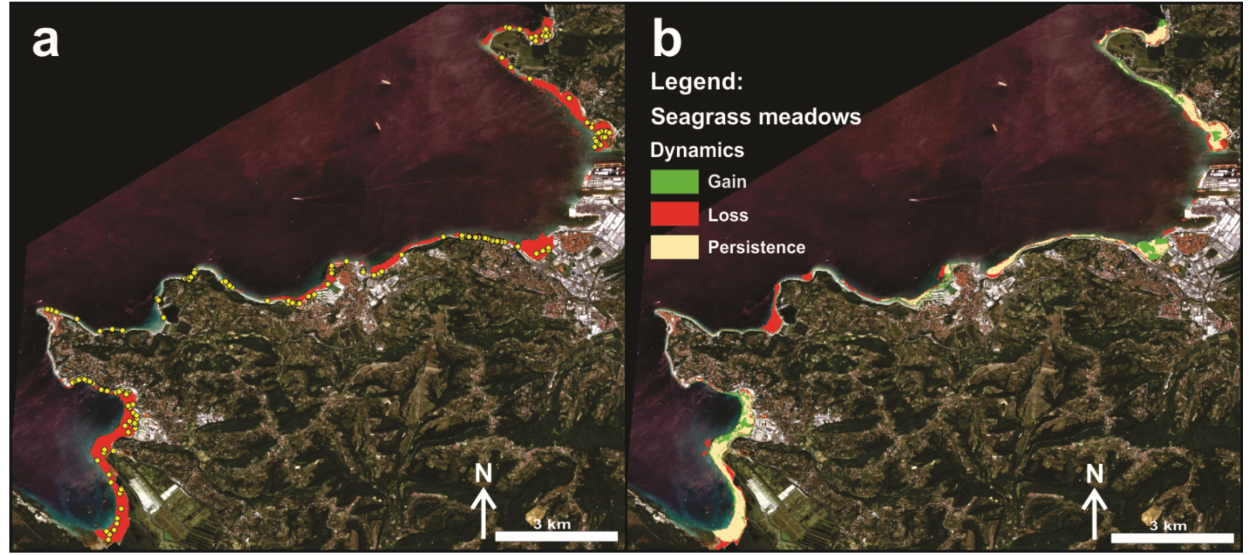
Figure 4. SVM classified pre-processed Sentinel-2 image showing: (1) a –seagrass cover in 2020 (red polygons are classified seagrasses, yellow dots are accuracy assessment points), and (2) b –seagrass dynamics along the Slovenian coast between 2014 and